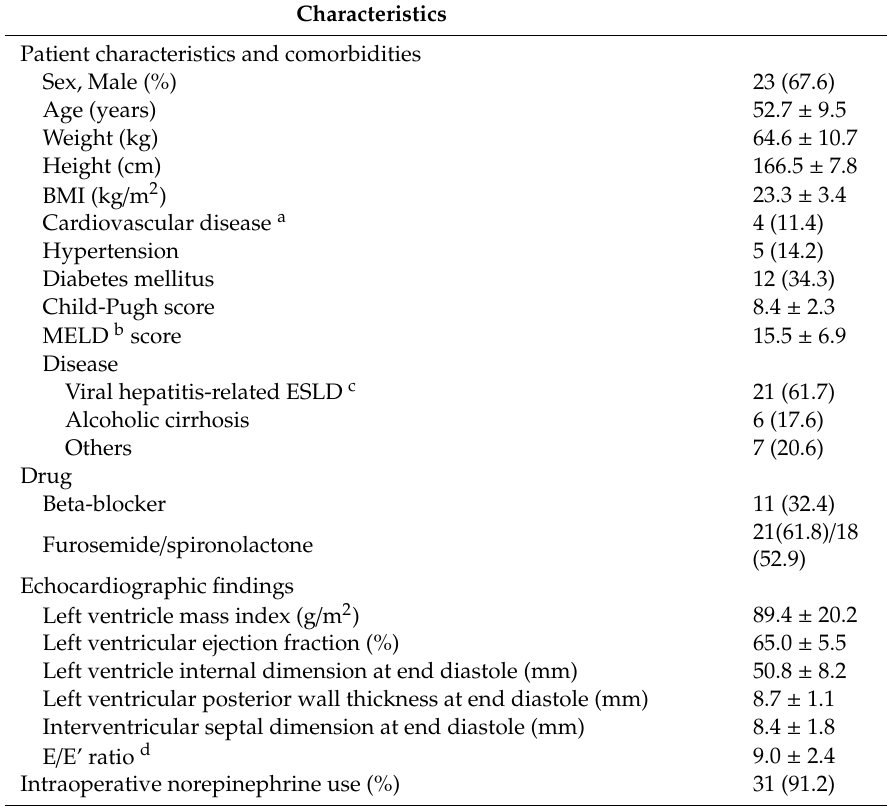
Table 1. Demographic and clinical characteristics of the 34 patients